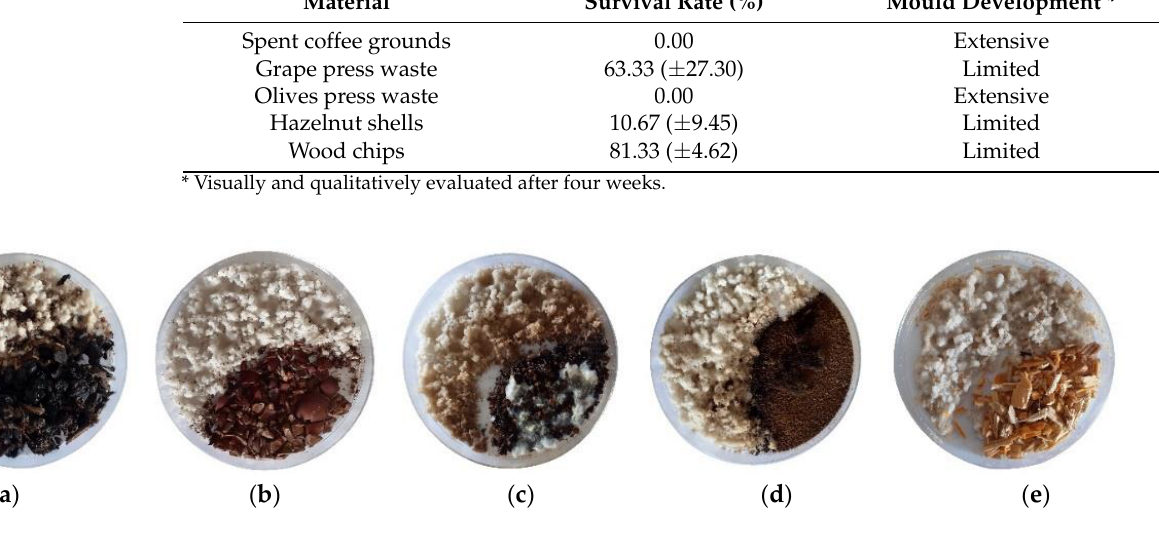
Table 9. Average rate (±standard deviation) of survival of R. grassei colonies for the bio-wastes. Material Survival Rate (%) Mould Development * Spent coffee grounds 0.00 Extensive Grape press waste 63.33 ( ± 27.30) Limited Extensive